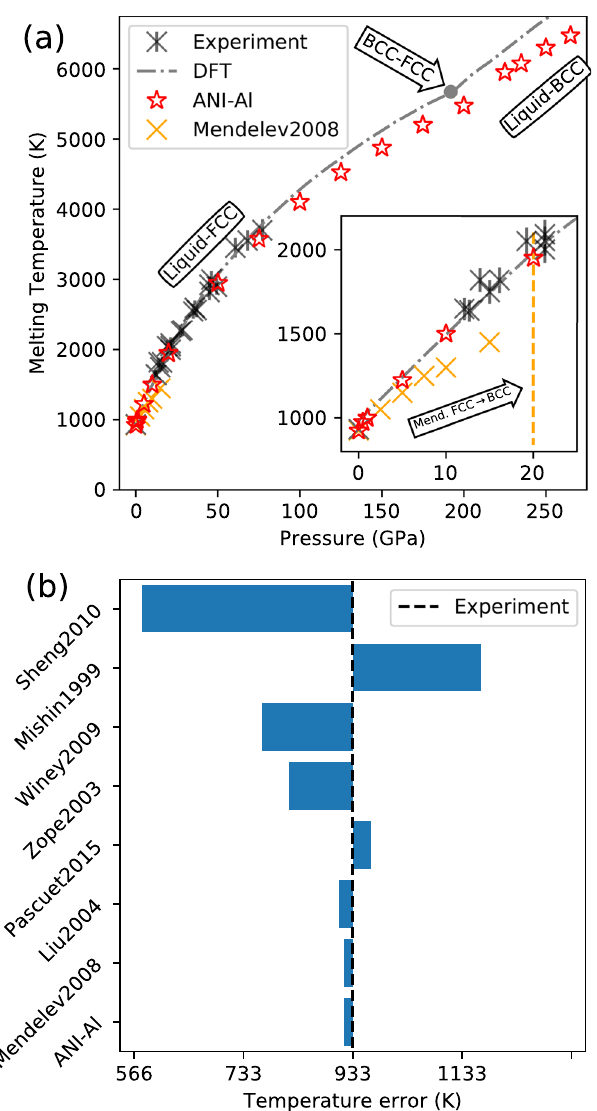
Fig. 5 Predicting melt temperatures. a Melt curve as a function of pressure for DFT 46 , ANI-Al, and the Mendelev et al. EAM potential 45 , compared with experimental data 73 . Below 210 GPa, we show FCC – liquid coexistence. Above 210 GPa, we show BCC-liquid coexistence. The inset zooms to pressures from 0 to 20 GPa. b Errors in predicting the melt temperature at atmospheric